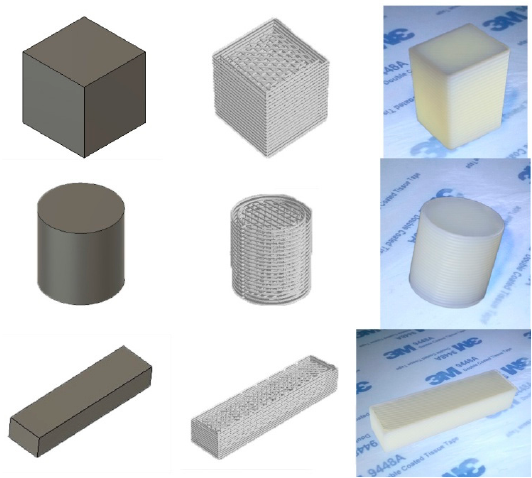
Figure 11. Test samples ( Left column) virtual models ( Middle column) slicer paths ( Right column) fabricated parts using silicone polymers.